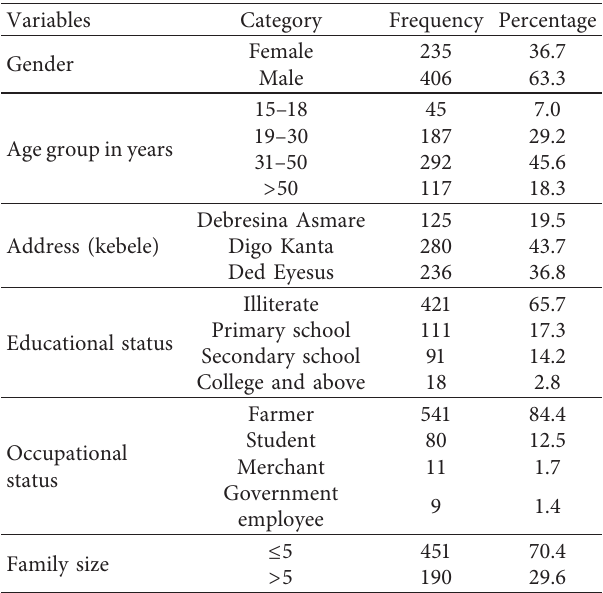
Table 1: Sociodemographic characteristics of study participants ( n � 641) in Bibugn Woreda, East Gojjam, Ethiopia, from February to September